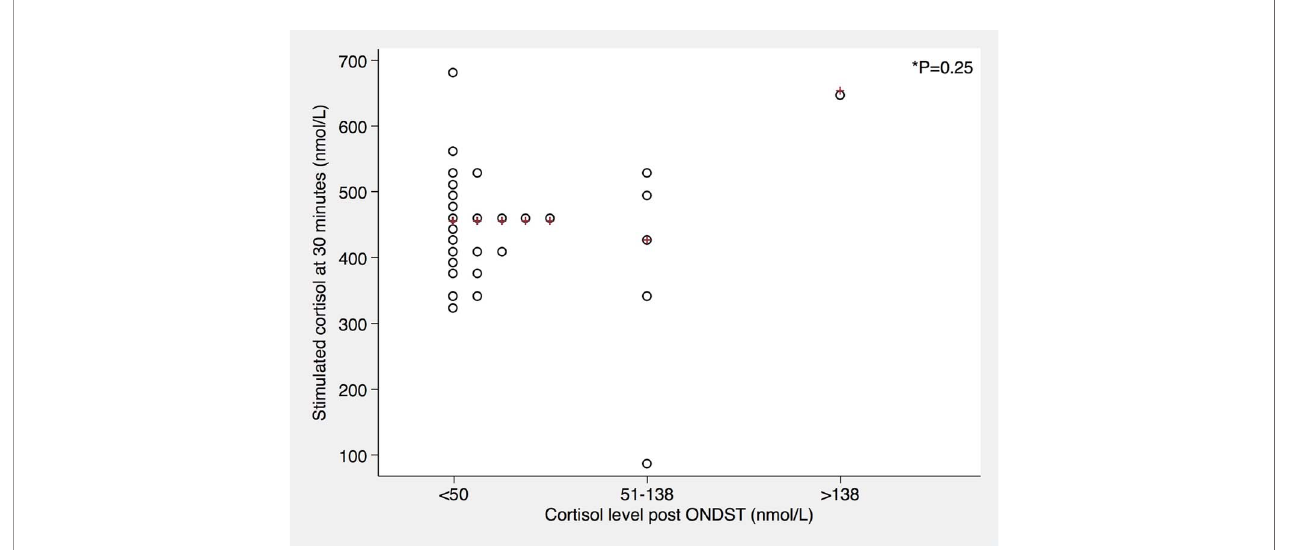
FIGURE 3 | Relationship between dexamethasone-suppressed cortisol levels and 30 minute synacthen-stimulated cortisol levels. Red crosses represent median values. P -value was derived from Kruskal-Wallis